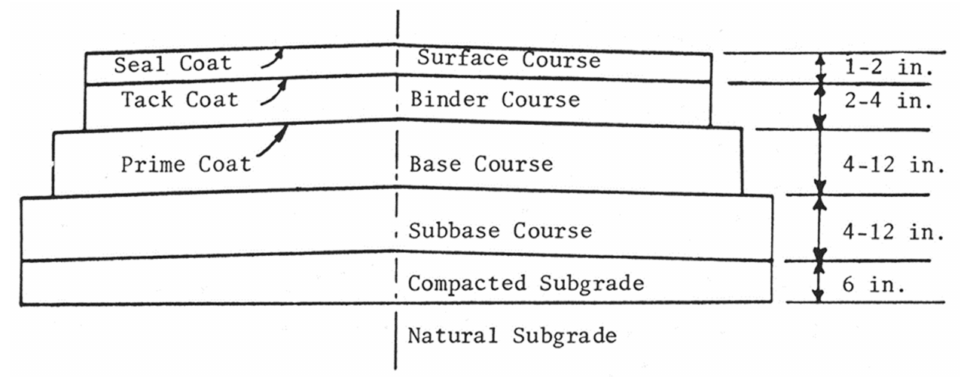
Figure 2. Typical cross section of the layered system in conventional flexible pavement